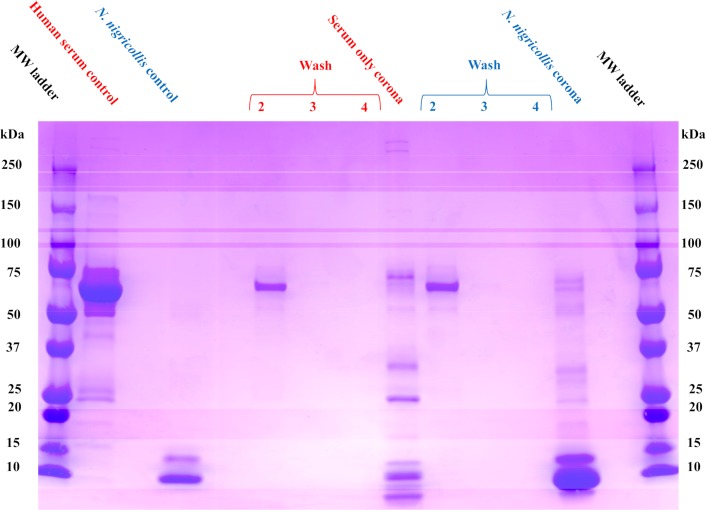
NP selectivity in human serum (red) and in human serum + N. nigricollis venom (blue).In the presence of serum alone, the NP favorably associates with proteins of varying molecular weights (Serum only corona band). A distinct change in the distribution and a new dominant molecular weight band (<15 kDa) in the N. nigricollis venom-containing corona band. Proteins that comprised this NP corona were identified via in gel digestion followed by proteomic identification.